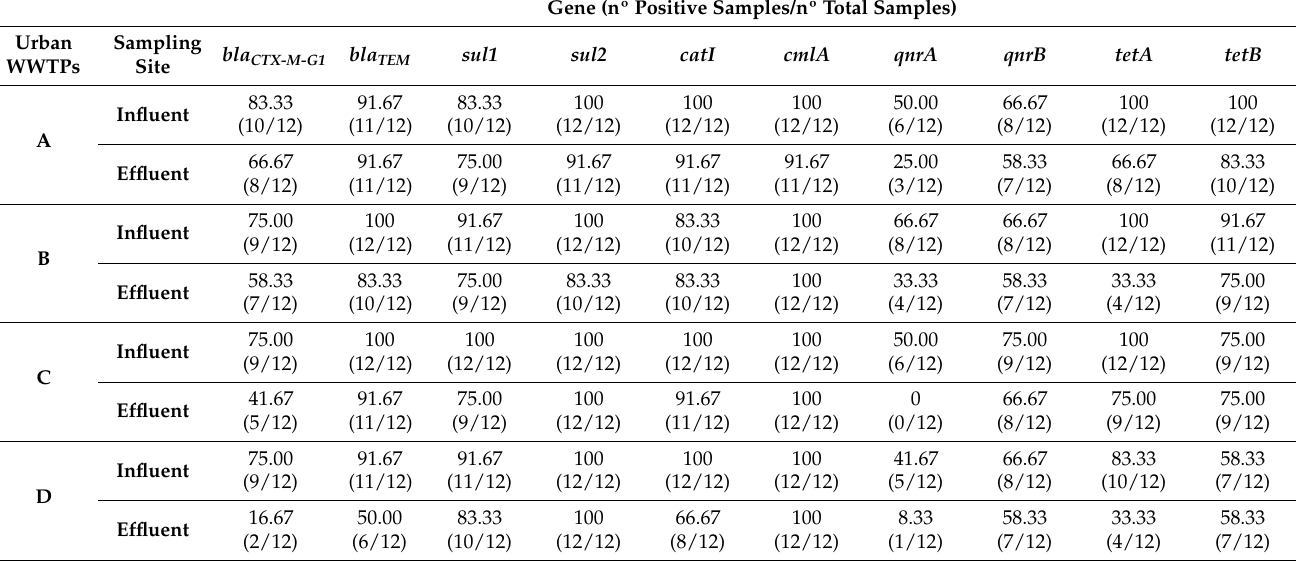
Table 3. Prevalence (%) of different ARGs detected in influent and effluent samples of each Urban Wastewater Treatment Plant